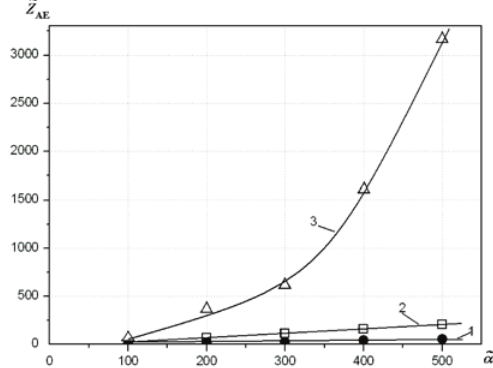
Fig. 4. Dependence of changes in AE resultant signal Z  ) with increasing friction unit rotation speed parameters ( AE of CM: 1( • ) – average amplitude; 2 ( ‪ ) – standard deviation of average amplitude; 3 ( D ) – average amplitude